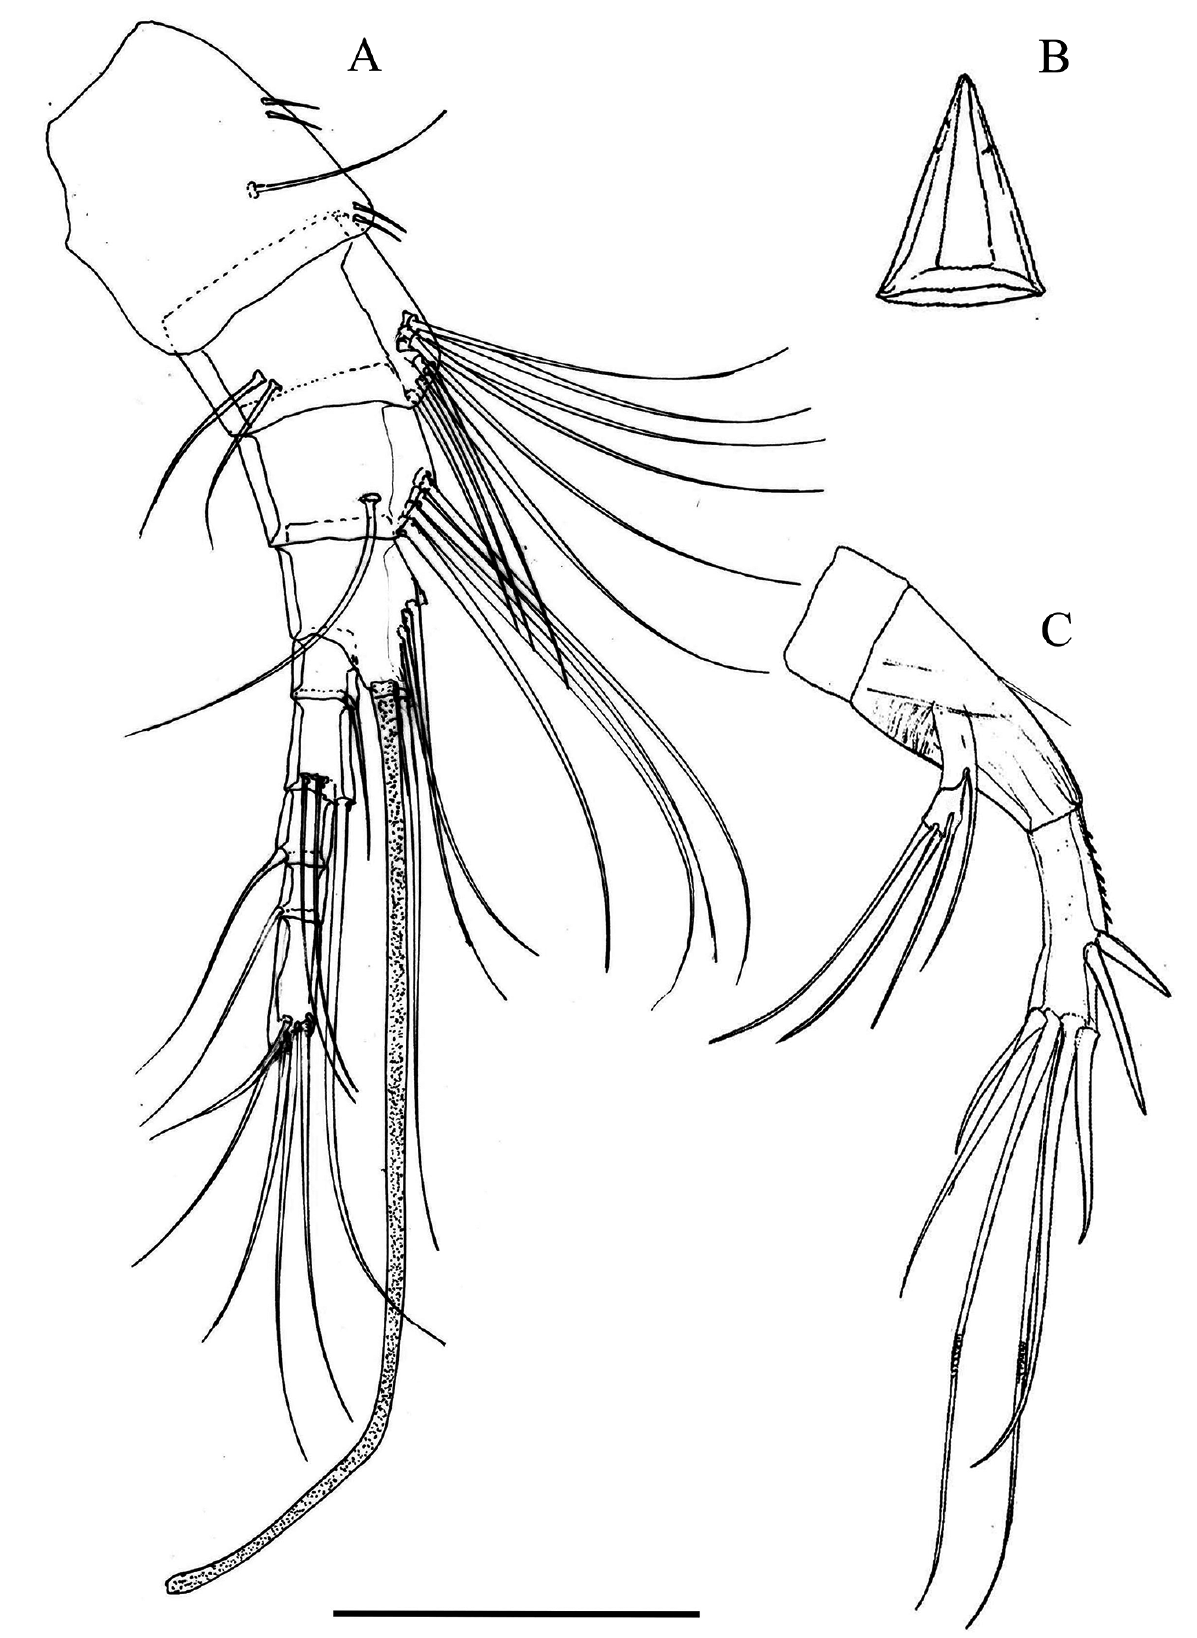
Figure 3. Eudactylopus fasciatus Sewell, 1940, female. A, Antennule, ventral view; B, rostrum; C, antenna, latero-dorsal view. Scale bar: 100